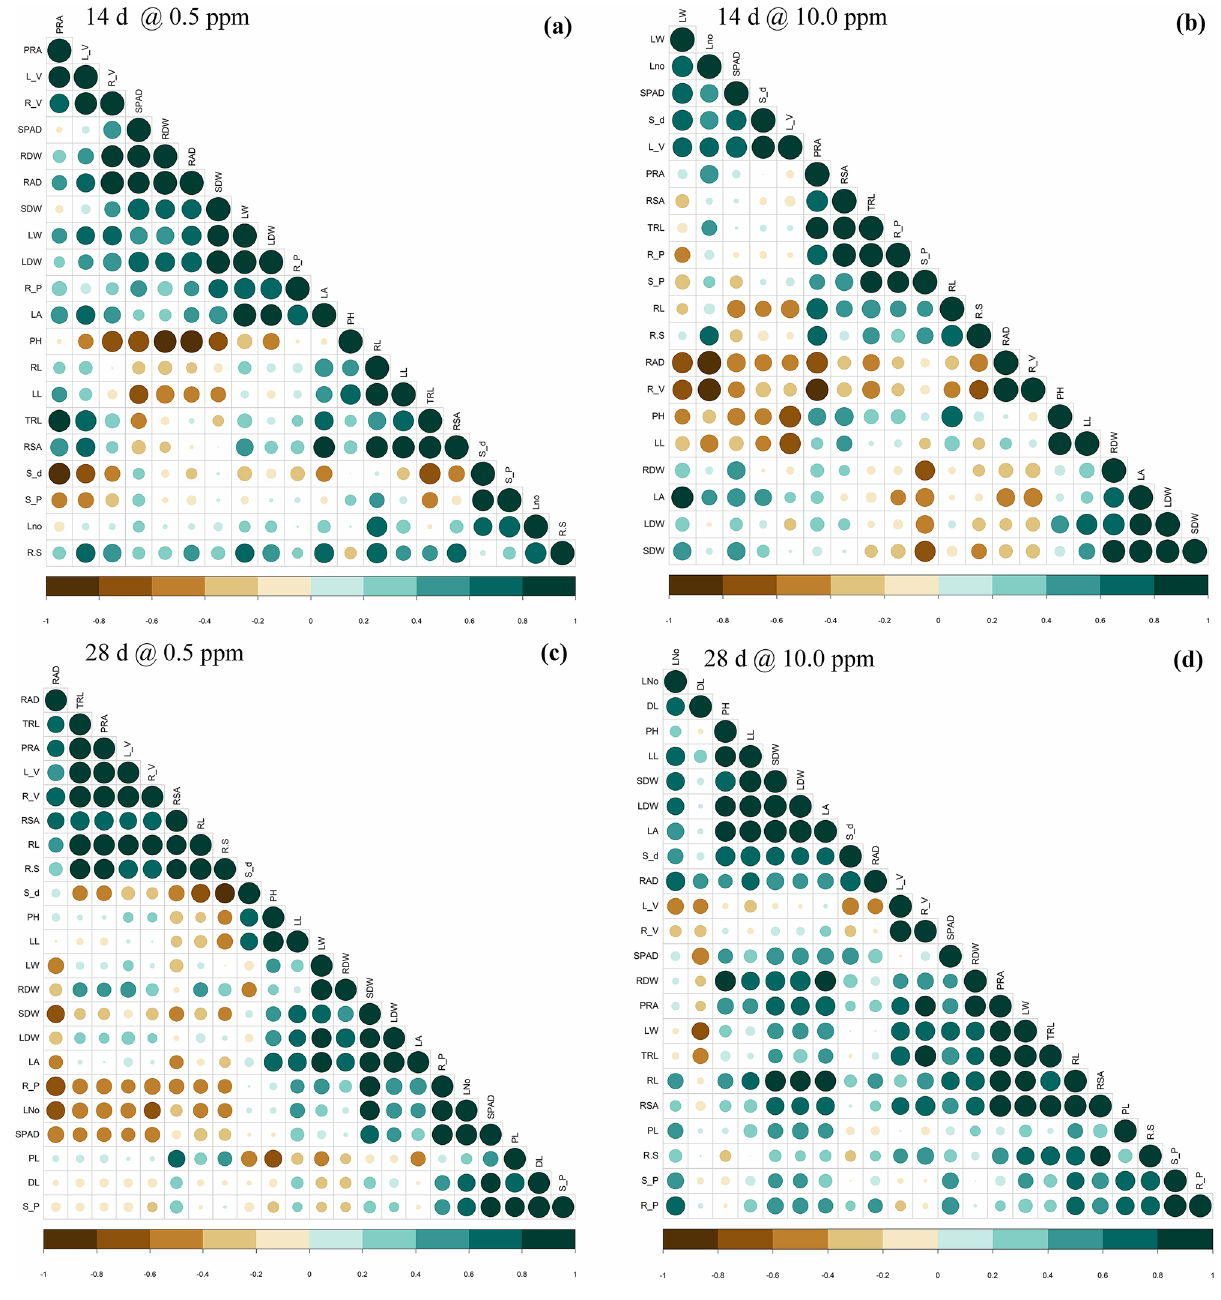
Figure 4. The correlation coefficient between morphological and physiological traits at 14 d and 28 d. a = correlation coefficient at 14 d in 0.5 ppm of P, b = correlation coefficient at 14 d in 10.0 ppm of P, c = correlation coefficient at 28 d in 0.5 ppm of P, and d = correlation coefficient at 28 d in 10.0 ppm of P. DL: number of dry leaves; L_V: root length per volume; LA: leaf area (cm 2 ); LDW: leaf dry weight (g); LL: leaf length (cm); LNo: number of leaves; LW: leaf width (cm); PH: shoot length (cm); PL: number of pigmented leaves; PRA: projected root area (cm 2 ); R.S: root-to-shoot ratio; R_P: root P content (mg/g); R_V: root volume (cm 3 ); RAD: average root diameter (mm); RDW: root dry weight (g); RL: max. root length (cm); RSA: root surface area (cm 2 ); S_d: stem diameter (mm); S_P: shoot P content (mg/g); SDW: shoot dry weight (g); SPAD; TRL: total root length